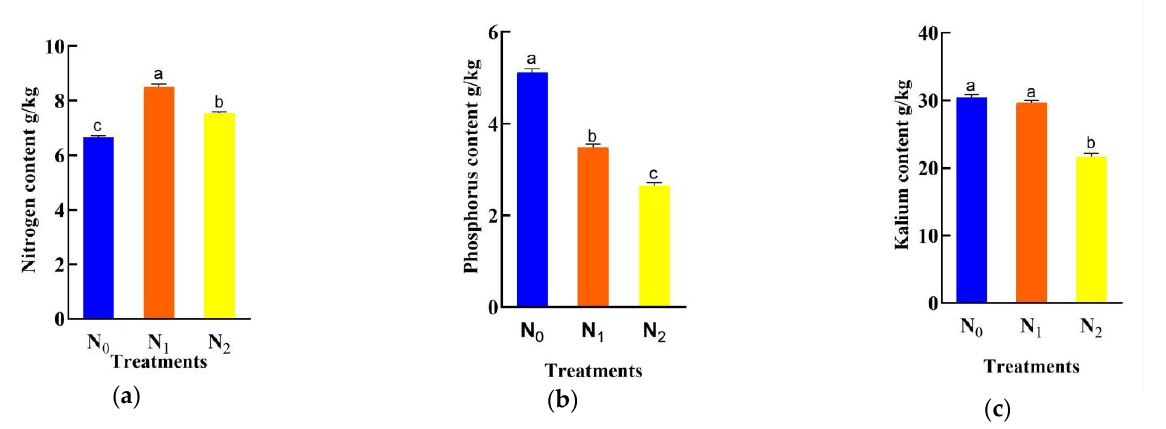
Figure 3. Significant analysis chart of nitrogen, phosphorus and potassium contents in maize under different nitrogen application treatments: ( a ) Significance results of nitrogen content in maize; ( b ) Significance results of phosphorus content in maize; ( c ) Significance results of potassium content in maize. Note: In the bar chart, “a, b, c” indicates that p < 0.05, they are arranged from large to small. Different letters indicate significant, and the same letters indicate insignificant.